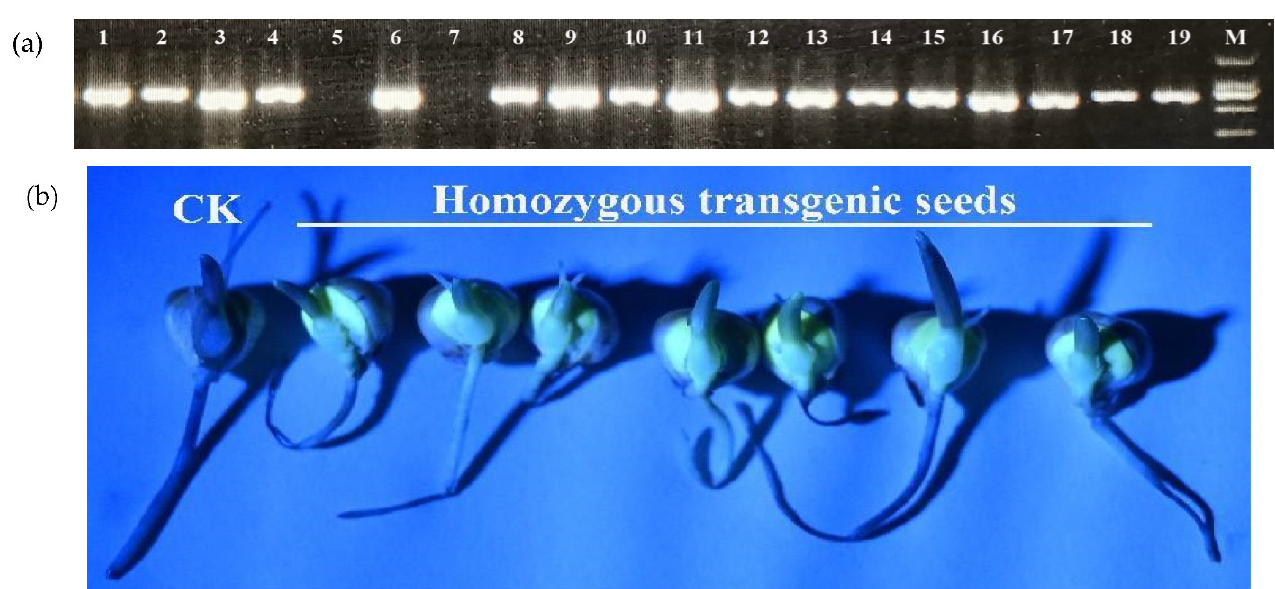
Figure 2. Acquisition of homozygous transgenic seeds by PCR and fluorescence detection. ( a ) PCR products of T 1 generation plants (lane 1–18; lane 5 and 7 are of negative plants), and pBIN-YA (B) plasmid (lane 19). M: DL 2000 marker; ( b ) fluorescence detection.